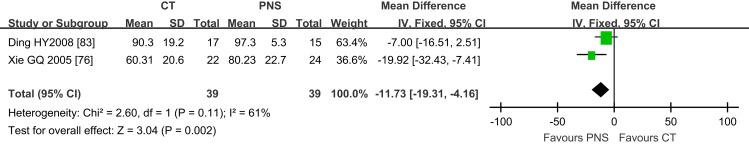
Results of meta-analyses on Barthel index (BI) (2 trials). PNS treatment significantly increased BI compared to RT (MD = -11.73; 95% CI = -19.31, -4.16; P = 0.002). PNS, Panax notoginseng saponin; CT, Current treatment.